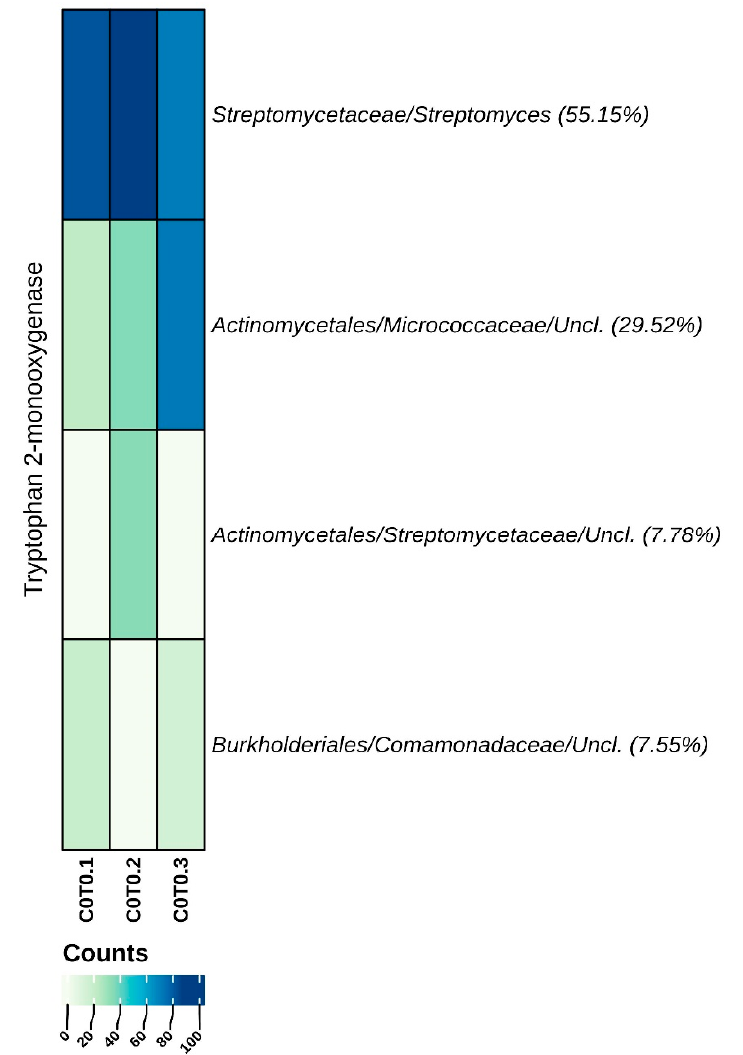
Figure 11. Functional Heatmaps of the Tryptophan 2-monoxygenase identified ASVs aggregated at the Genus level, as inferred by PICRUSt2 in the three biological replicates. On rows, the nearest identified taxonomic level for each contributing ASV is reported, followed by their relative percentage of contribution to the functional feature. Hierarchical clustering of columns was performed by Pearson correlation, based on Euclidean distance.